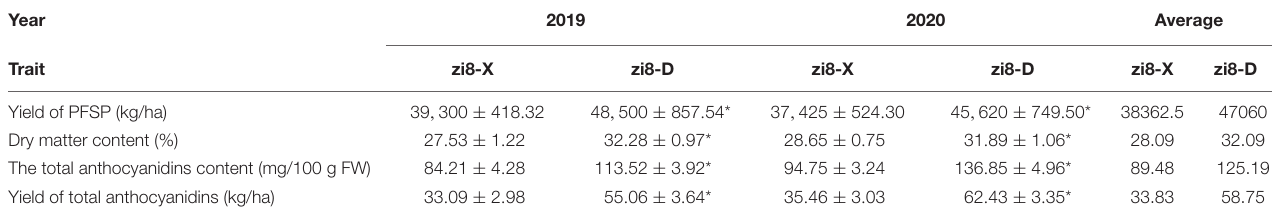
TABLE 1 | The total anthocyanidins content and yield of anthocyanidins.